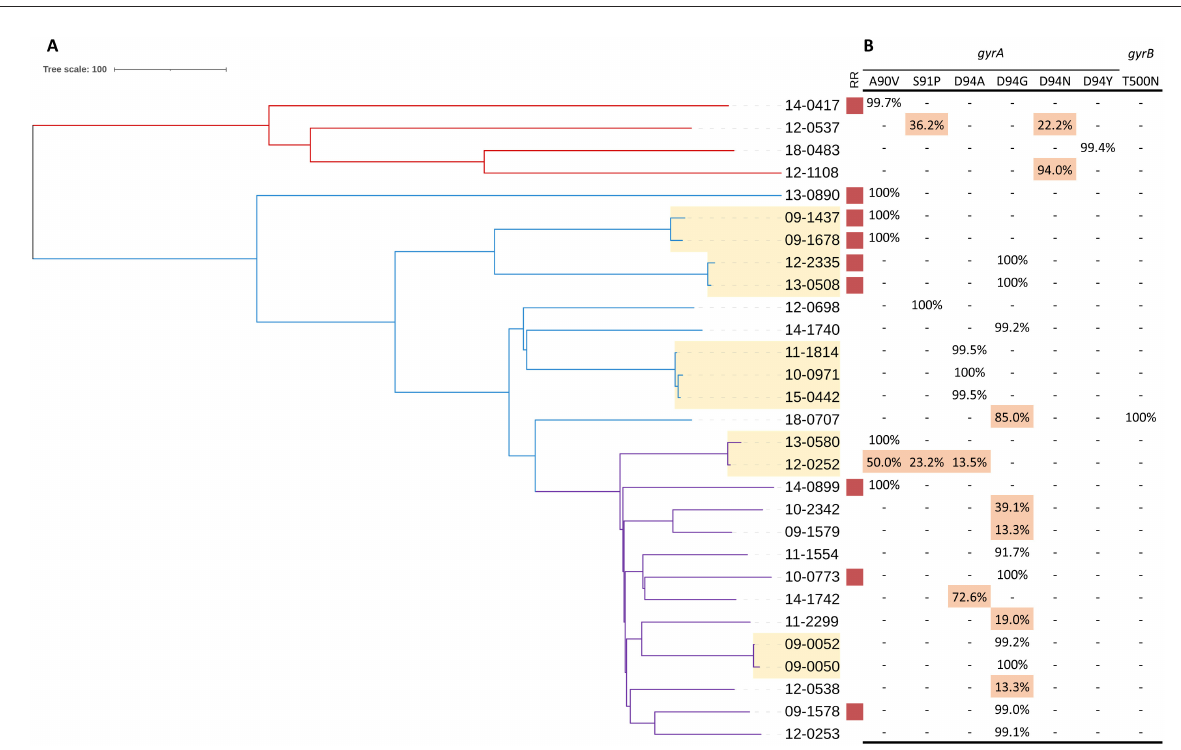
FIGURE1 Phylogeny, clustering and FQ hetero-resistance profile of 29 FQ-resistant MTB isolates. (A) Red, blue and purple branches indicate Lineage 4, ancient Beijing and modern Beijing strains, respectively. Genomic-clustered strains differing by ≤ 12 SNPs are highlighted in yellow. Red square indicates the MTB isolate resistant to rifampicin. (B) Allele frequency of FQ resistance-conferring loci in gyrA and gyrB . Hetero-resistance mutations are highlighted in